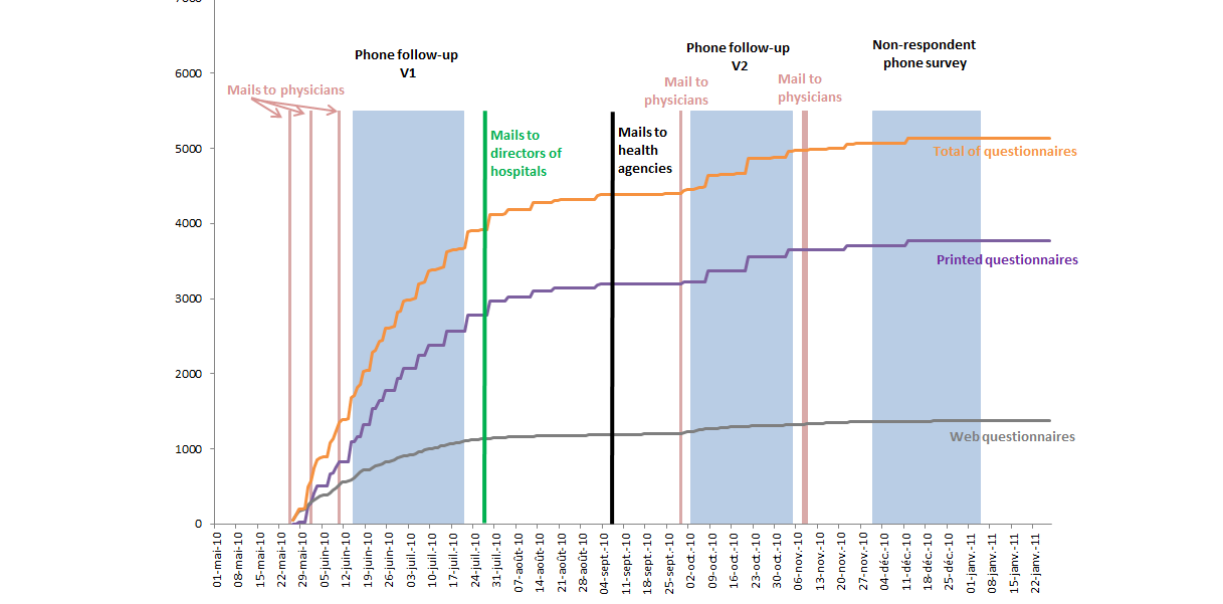
Figure 1. Schedule of data collection fieldwork and number of questionnaires by data collection